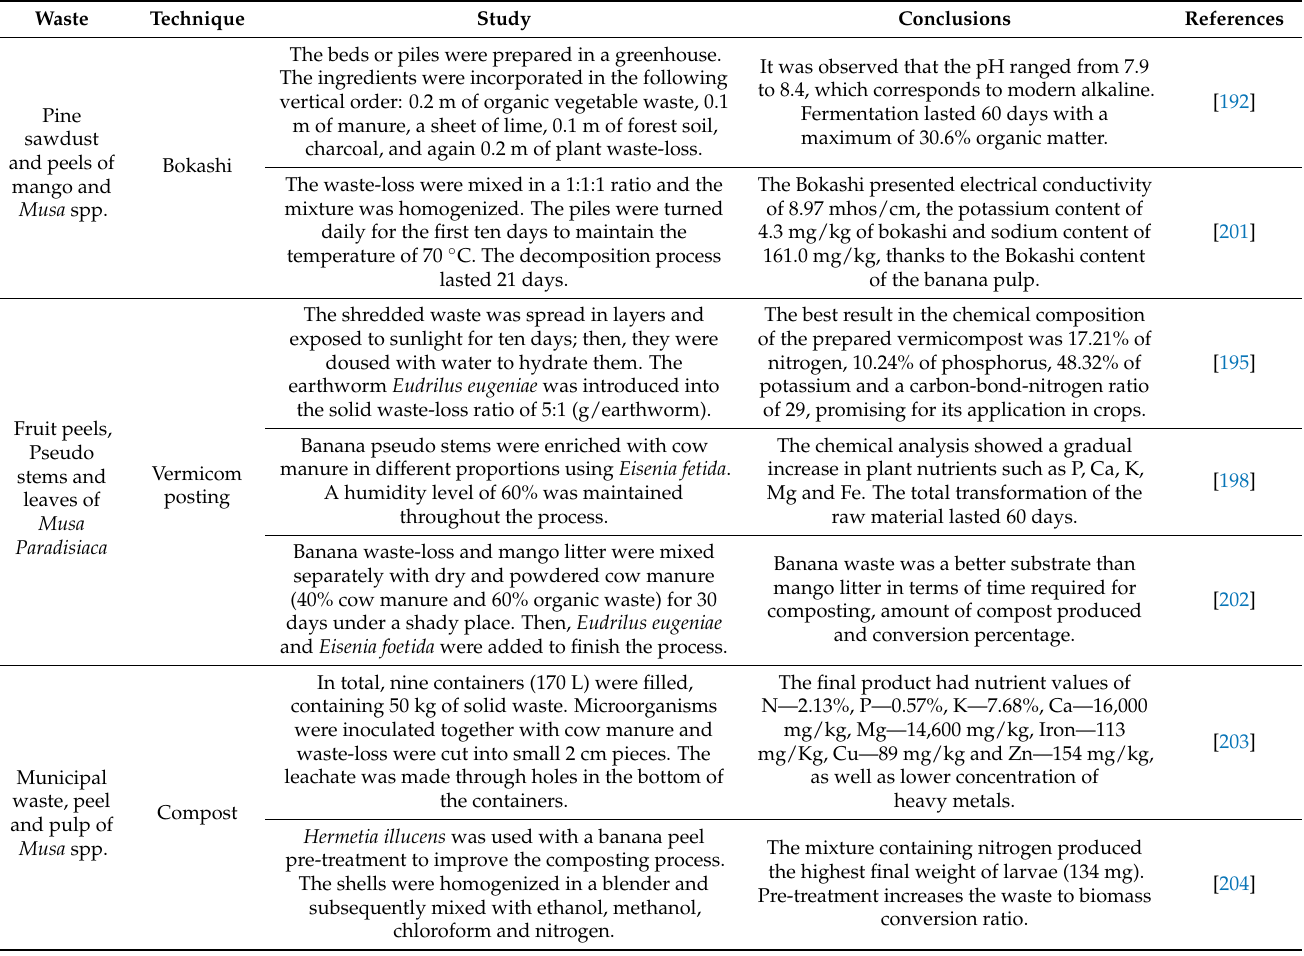
Table 10. Studies on the production of organic fertilizers from banana